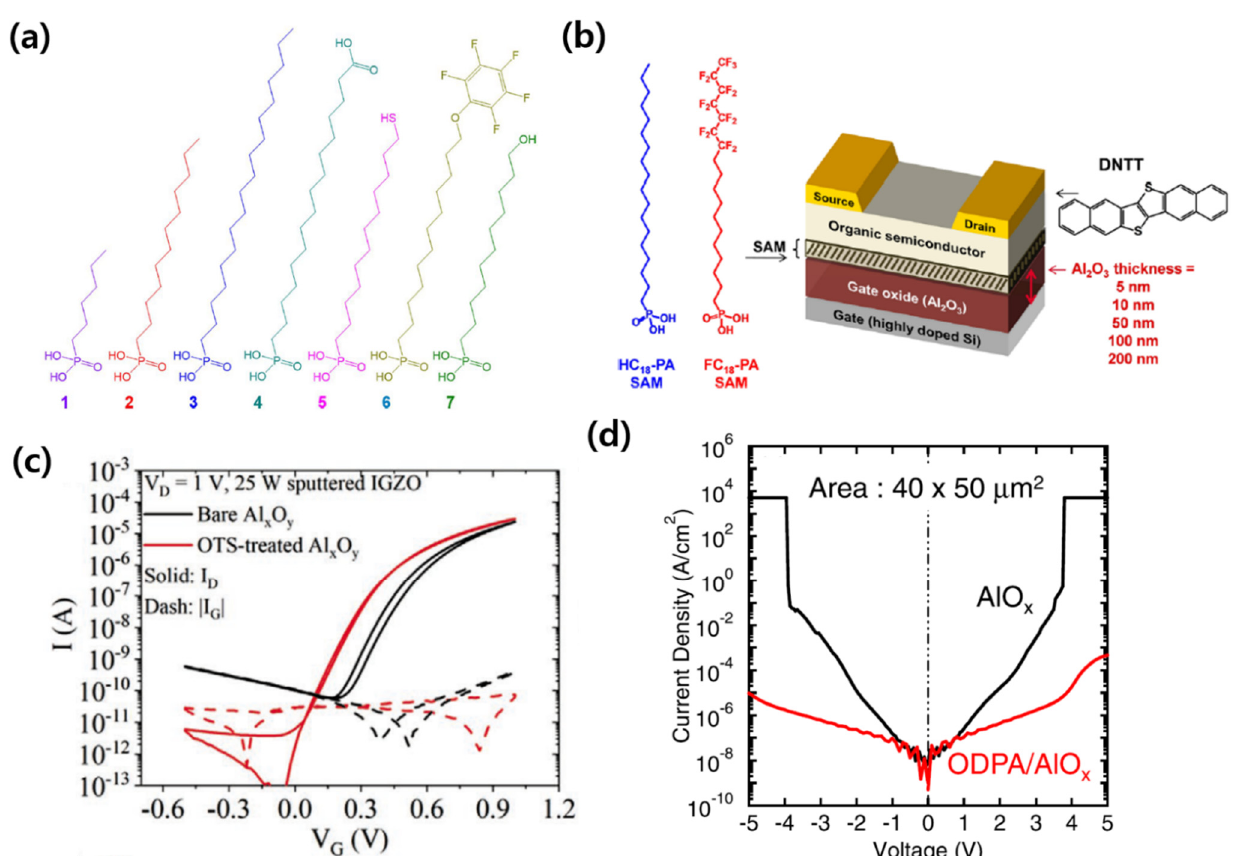
Figure 2. SAM treatment on Al 2 O 3 gate dielectrics. ( a ) Chemical structures of various phosphonic acid SAMs. [1: Hexylphosphonic acid (HPA), 2: dodecylphosphonic acid (DDPA), 3: octadecylphosphonic acid (ODPA), 4: 16-phosphonohexadecanoic acid (PHDA), 5: 12-mercaptododecylphosphonic acid (MDPA), 6: 12-pentafluorophenoxydodecylphosphonic acid (PFPA), 7: 11-hydroxyundecylphosphonic acid (HUPA)] (adapted from [41] with permission from Springer Nature). ( b ) Schematic of a DNTT transistor to compare the effect of two phosphonic acid SAM treatments for the thickness of Al 2 O 3 gate dielectrics (ODPA, FDPA) (adapted from [42] with permission from the American Chemical Society). ( c ) Transfer characteristics of an IGZO transistor with and without ODTS on Al 2 O 3 (adapted from [43] with permission from John Wiley and Sons). ( d ) Comparison of the gate leakage current with or without the ODPA treatment of Al 2 O 3 (adapted from [44] with permission from AIP Publishing).